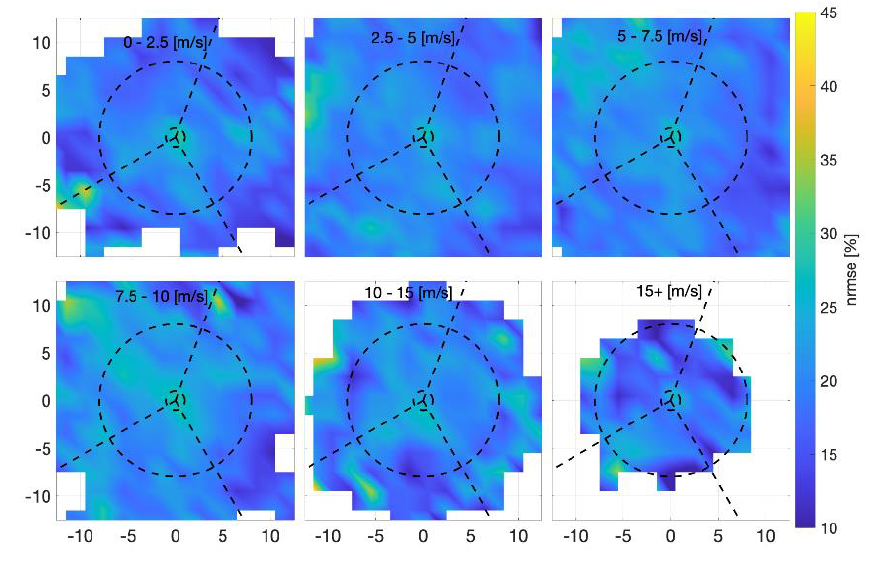
Figure 16. As in Figure 14, each subplot parsed by forward translation velocity.